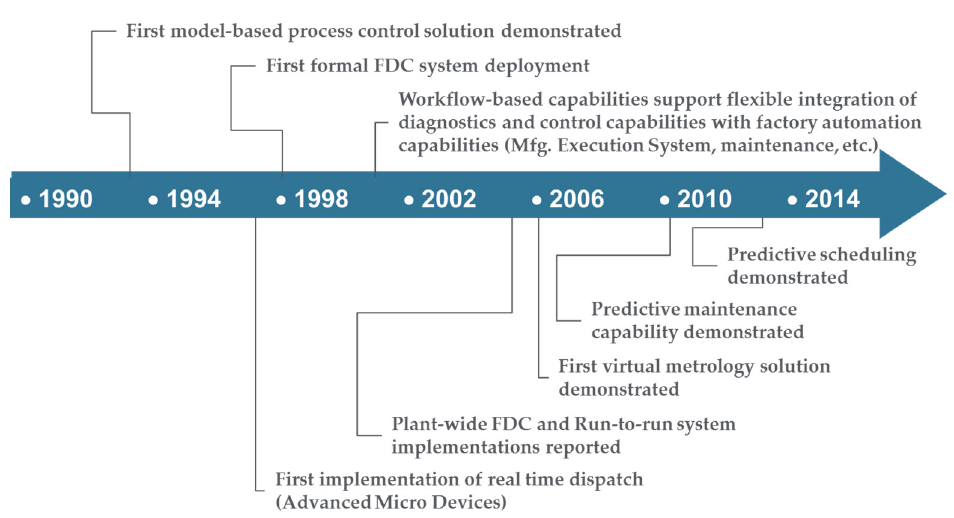
Figure 1. History of process analytics in semiconductor manufacturing. Dates are approximate and determined from an analysis of publications in Advanced Process Control Conferences, with permission from [6,12], Copyright Advanced Process Control Conferences 2016.